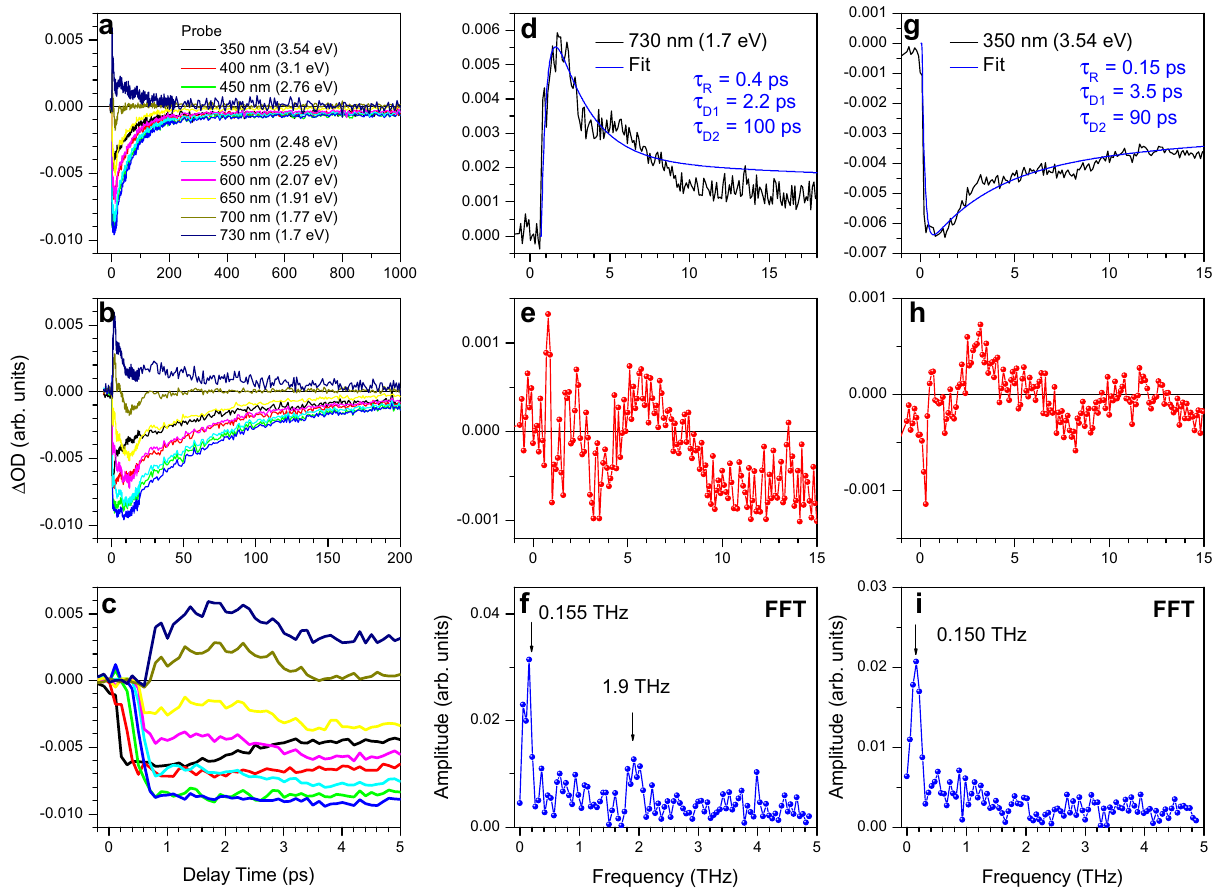
Figure 5. The pump–probe traces of the gapped topologically nontrivial insulator phase of the 2D TI Bi 2 Se 3 . ( a – c ) The pump–probe traces for the 5 QL thick Bi 2 Se 3 film, which were measured with the 340 nm (3.65 eV) pumping of 0.5 mW power at the specific probe wavelengths, as indicated by the corresponding colors and plotted using different timescales. ( d ) and ( g ) Some of the traces shown in parts ( a – c ) and the corresponding fits, as indicated. The corresponding rise-time and decay-time constants are listed for both panels. ( e ), ( h ) and ( f ), ( i ) The extracted oscillatory parts of the pump–probe traces shown in parts ( d ) and ( g ) and the corresponding fast Fourier transformation (FFT), respectively. The center frequencies are indicated in parts ( f ) and ( i